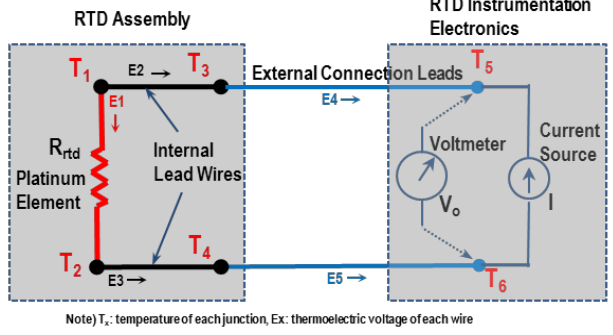
Fig. 1 Unintended TC elements in RTD connection